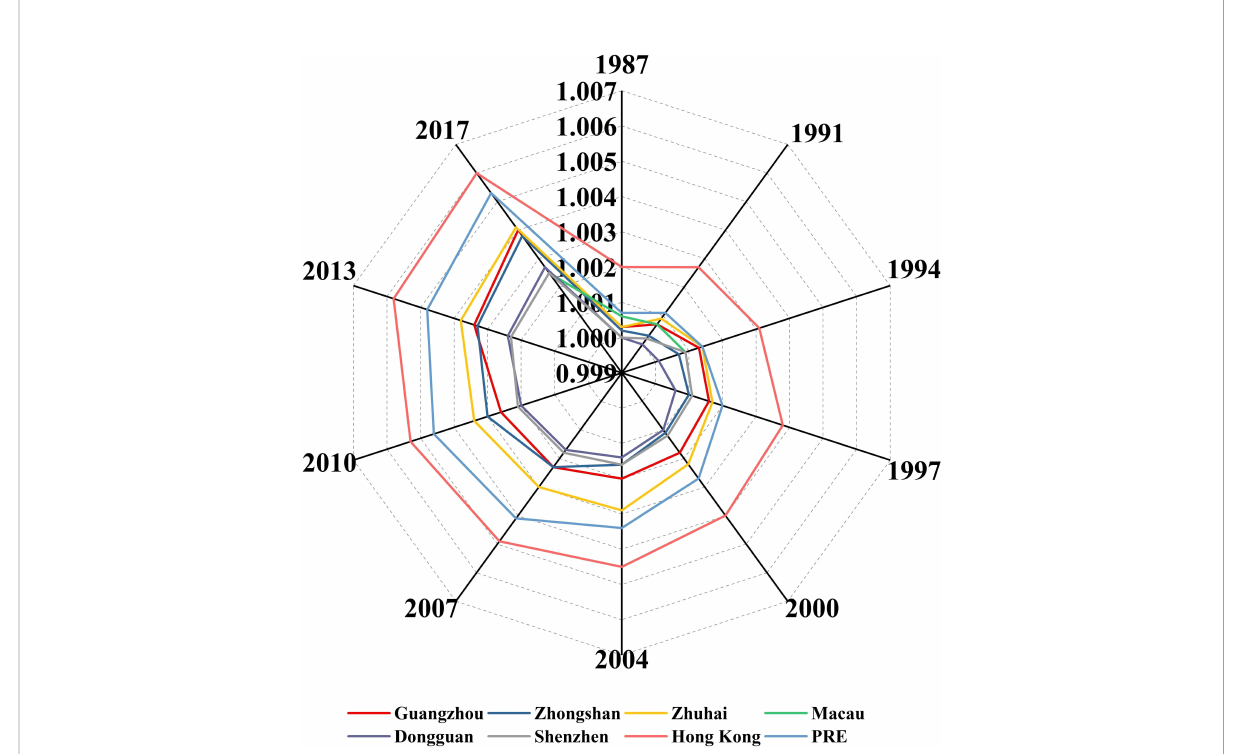
FIGURE 6 Fractal dimension variations of the coastline in different cities of the Pearl River Estuary during